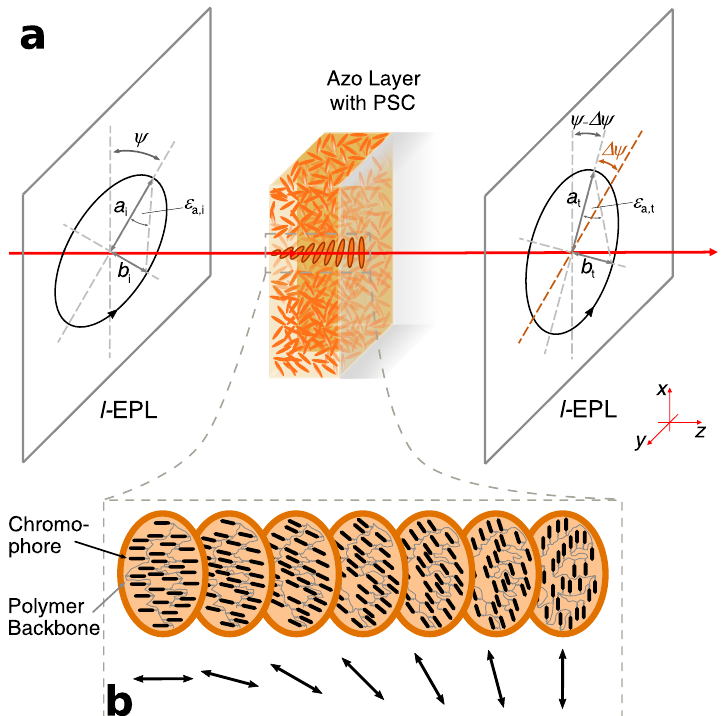
Figure 2. Schematical visualization of optical rotation and a possible explanation for molecular rearrangement upon irradiation with excitation beam. ( a ) Polarized light with the parameters ψ a,i , (cid:101) a,i , a a,i , and b a,i . The subscript ascribes characteristics of: “a”: analysis beam; “i” : incident beam; “t”: transmitted beam. ( b ) A possible visualization of molecular rearrangement causing supramolecular chirality. Double-headed arrows refer to the mean orientation of azo molecules in each layer. This figure shows PSC and the resulted optical rotation only